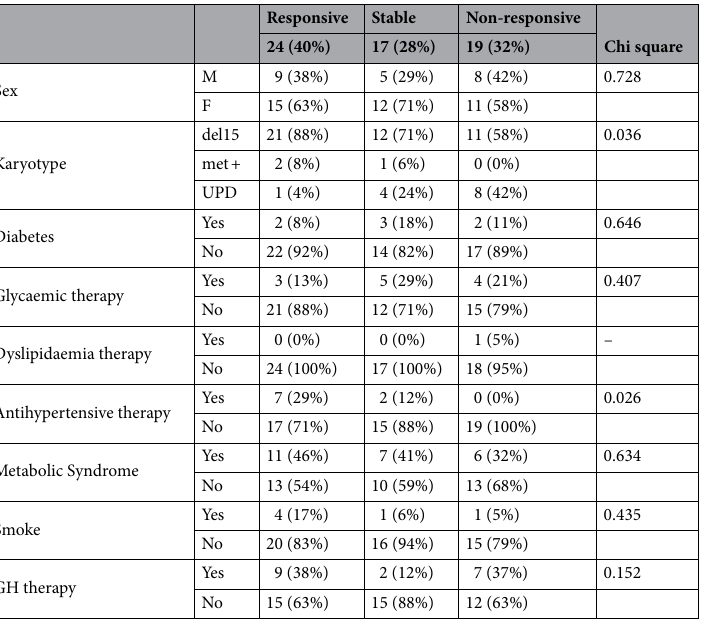
Table 4. Frequency of Prader–Willi syndrome (PWS) patients’ main characteristics in responsive, stable and non-responsive subjects at baseline. Variables are reported as the number and proportion of subjects with the characteristic of interest. p < 0.05: frequency significantly different between groups. Del15: deletion in chromosome 15 Karyotype; Met+ : diagnosis of Prader–Willi through methylation test (Karyotype unknown); UPD: uniparental disomy Karyotype